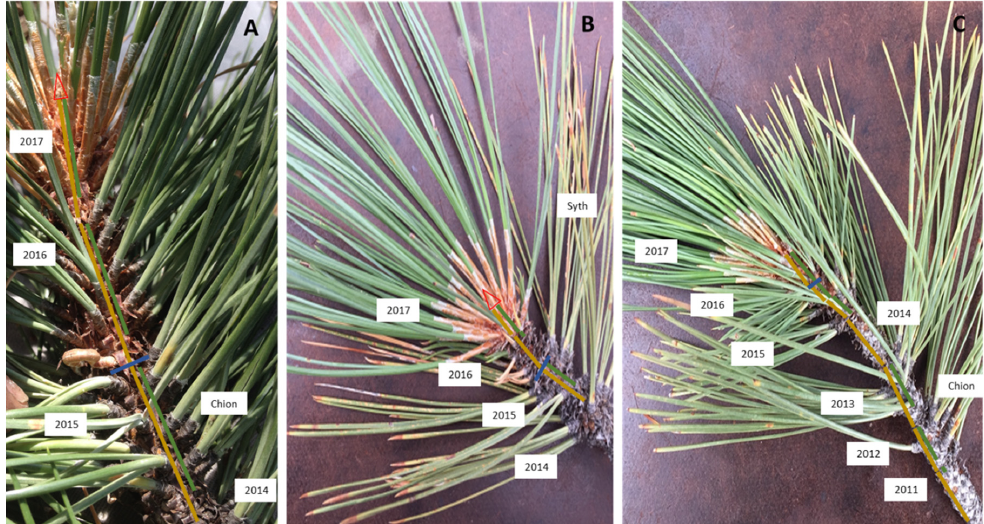
Figure A1. Examples of branchlets illustrating variability of di ff erent crown trait measurements. ( A ) Branchlet was clipped from a tree in a mesic (M) microsite. Four needle ages (WHL) are labeled by year, with CHL1 and CHL2 with 0% chlorosis for the first two years of needles (CHL1, CHL2), and CHL3 with 15% chlorosis. A needle defoliator, scale ( Chionaspis , spp.; Chion), is present on the 2015 needles. Branch length (BRLNx) by year (x) is indicated by a dark mustard bar, with the foliated portion (%FOLLNx) of each year indicated by a dark green bar. An open red triangle indicates the position of the preformed 2018 terminal bud. The blue bar perpendicular to the branchlet axis indicates measurement point of prior year branchlet diameter (BRDIA2). ( B ) Branchlet was clipped from a tree in a xeric (X) microsite. Four needle ages were retained, with 40% and 60% chlorosis for CHL3 and CHL4, respectively. Needle length measured after elongation growth has ceased is presented relative to the average length of needles, of the whorl with the longest needles retained on the branchlet (%MxNLx): 100% for 2017 (total length not apparent in the photo); 5% for 2016; 60% for 2015, and 45% for 2014. The e ff ects of a needle defoliator, Scythropus , spp. (Scyth) is present on the 4th year needles. ( C ) Branchlet from another X tree. The oldest needles are seven years old, but the 2014 needles were excised. Because the 2014 branchlet elongated, and the bracts for each needle fascicle (cluster of three needles bundled by a paper sheath) are widely spaced, it is likely that the needles elongated but were lost to reduce leaf area with increasing drought through 2016. The oldest WHL retained only one fascicle. % MxNL2 is 20% (compare to 5% in Panel (B)), 40% for MxNL3, and 60% for MxNL4. Trees di ff er in their respond to hydrologic deficits, especially in xeric microsites likely due to di ff erences in the amount of trapped water in bedrock interstices. Whole tree examples of early senescence (ES) can be found in [53] and DMR in [57]. Table A1. List of all whole tree, crown morphological, and spectral traits, their mean or median in each tree group and a brief description of trait. References for trait selection are given in Methods. Column legends: trees in mesic microsites with background N microsites (M BN), mesic plus